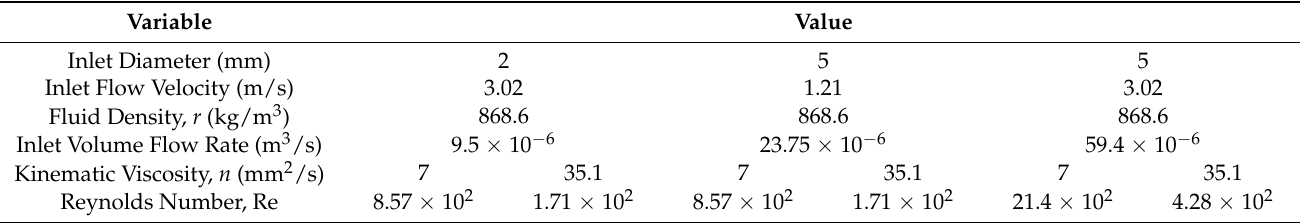
Table 1. Physical properties and numerical